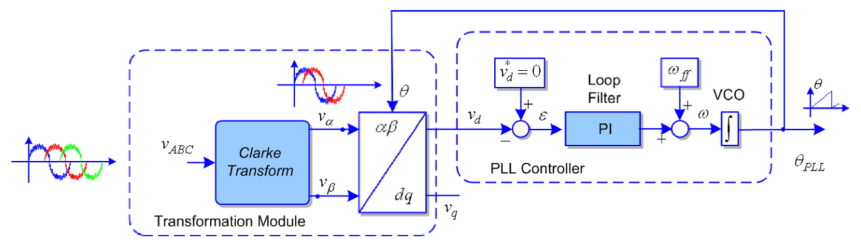
Figure 3. Phase locked loop to synchronize the DVR to the supply voltages.